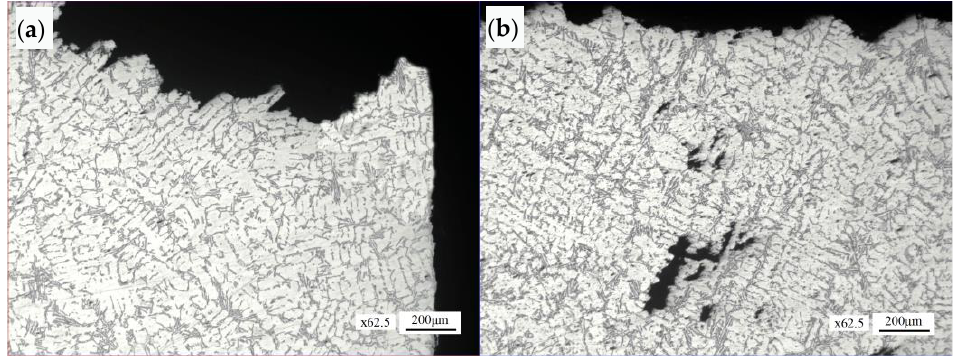
Figure 11. SEM morphology of the hinged plate: ( a ) fracture propagation region, ( b ) final fracture region.